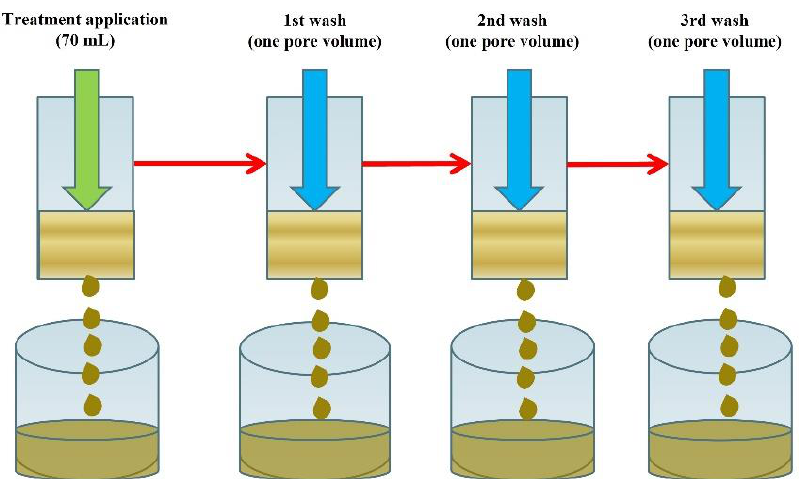
Figure 1. Schematic illustration of the experiment process. The sand columns were subjected to treatment application and 24 h after, deionized, distilled water at one pore volume (58 mL for hydrophobic sand and 54 mL for fresh sand) were used to wash the sand columns three times at a 30-min interval between each wash. Without disturbing the sands, the sand columns were then subjected to oven drying at 50 ◦ C for 7 days, before additional treatment applications and triple washing occurred, as described for the first cycle. The entire process was carried out three